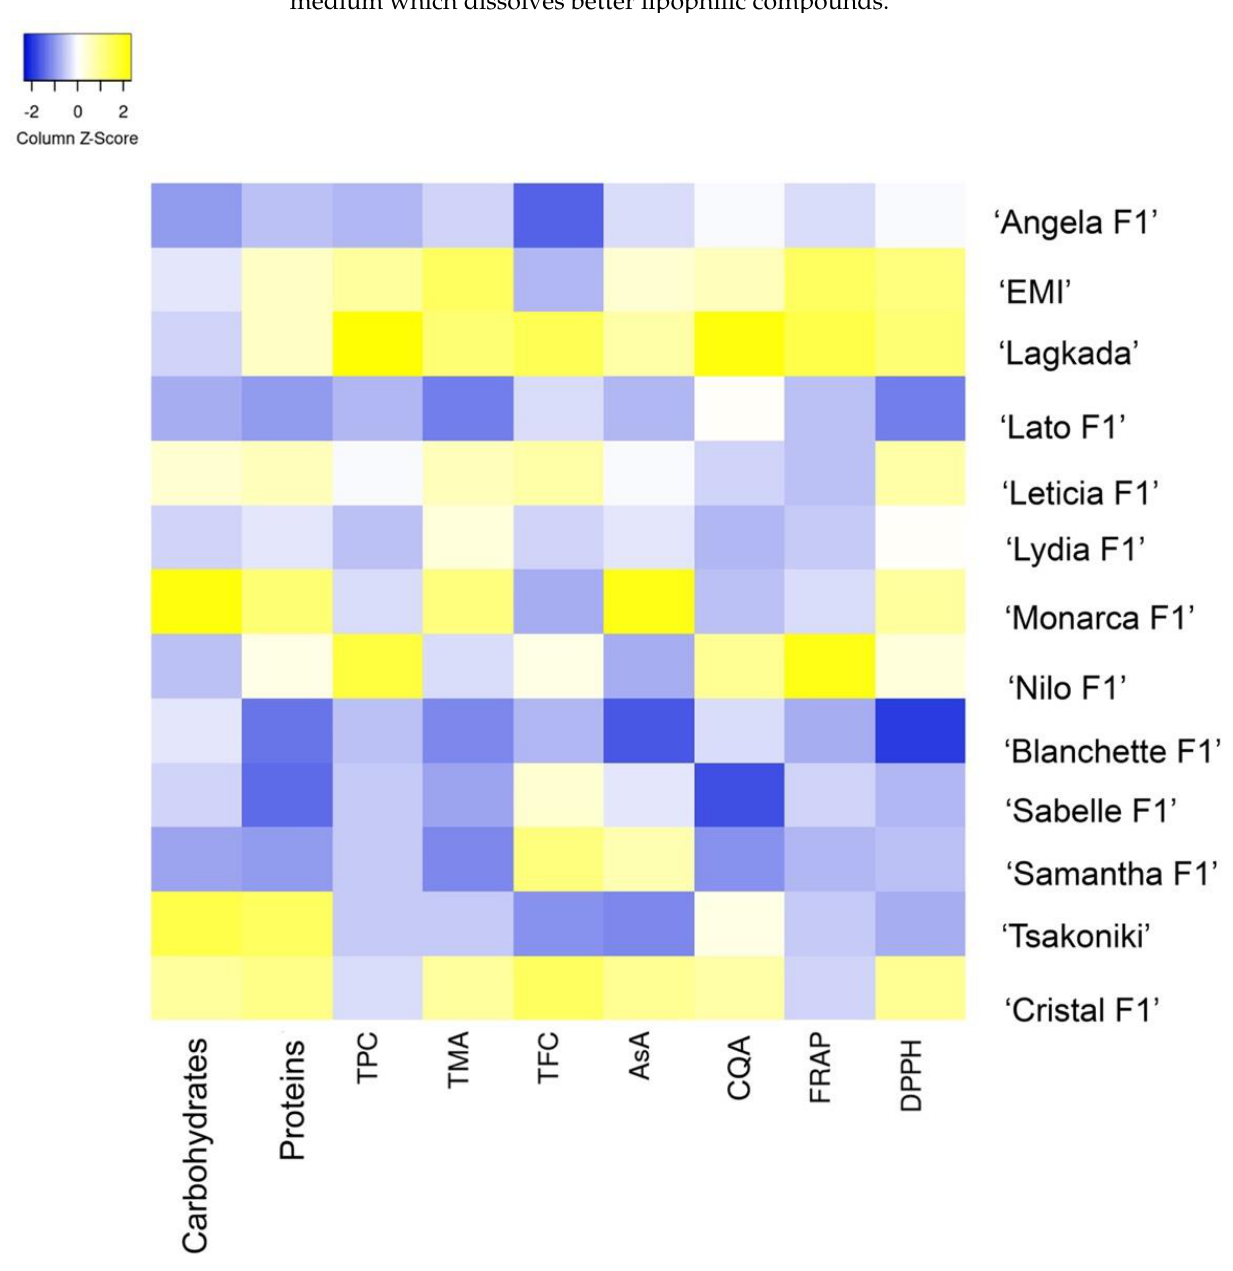
Figure 1. Heat map showing the variation of total sugars, proteins, phenolics (TPC), anthocyanins (TMA), flavonoids (TFC), ascorbic acid (AsA), caffeoylquinic acid (CQA), and the antioxidant properties by FRAP and DPPH scavenging assays in 13 eggplant cultivars. Standardized values (z-scores) of mean values are depicted with a color scale (from blue to yellow).